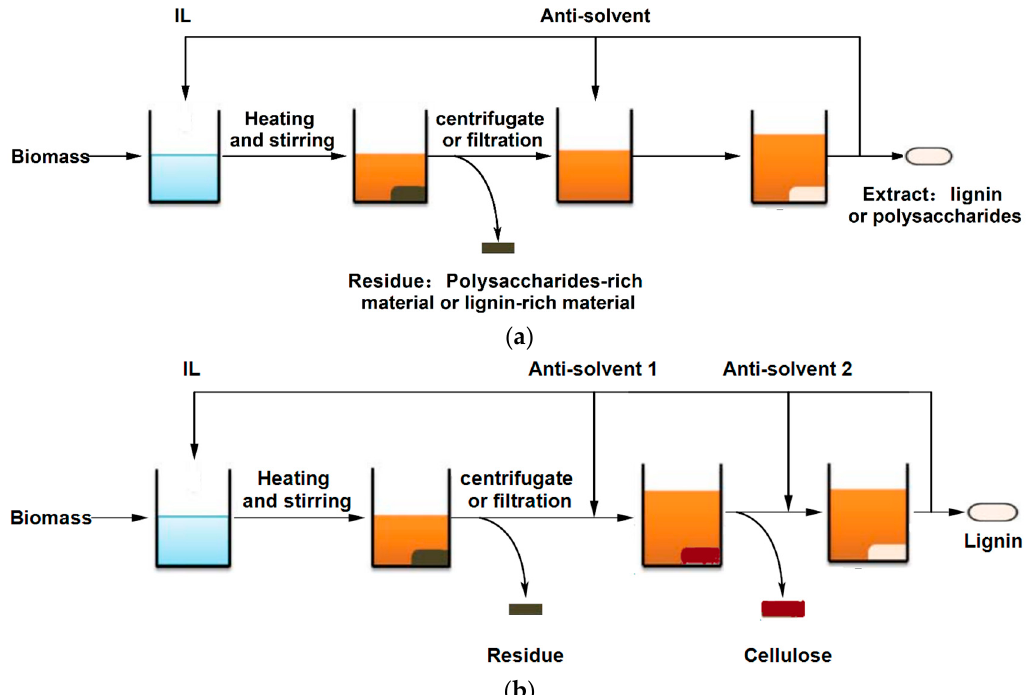
Figure 2. Fractionation procedure of lignocellulose with ILs: ( a ) one-step extraction of lignin or polysaccharide using selective ILs and ( b ) two-step separation of cellulose and lignin with non-selective ILs. Adapted from Reference [73] with permission from The Royal Society of Chemistry. Table 3. Separation and recovery of lignin from biomass using ILs and IL-based solvent systems.